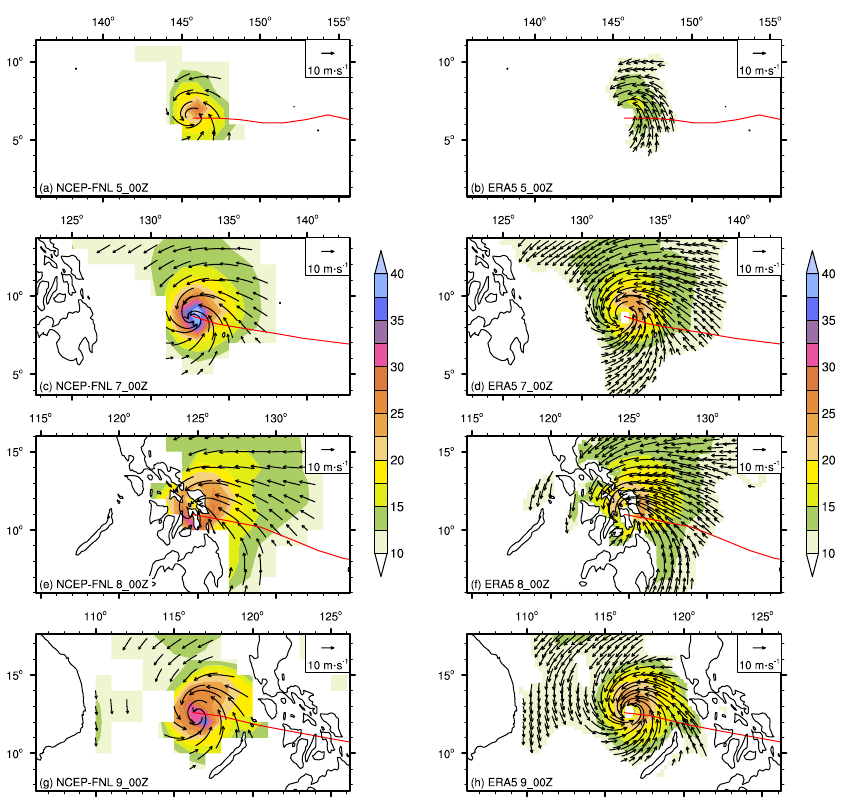
Figure 6. Wind fields of super-typhoon Haiyan in atmospheric analysis/reanalysis. ( a , c , e , g ), NCEP- FNL, ( b , d , f , h ) ERA5.